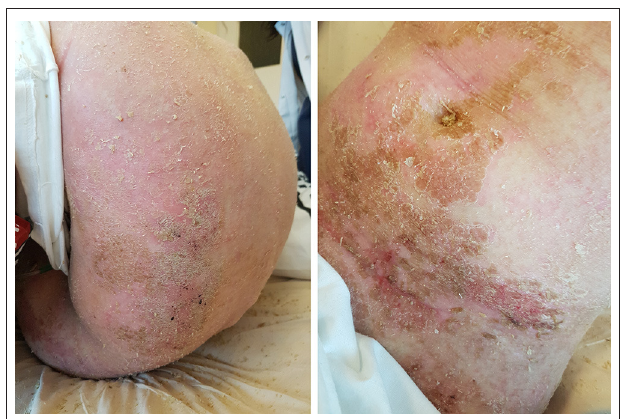
FIGURE 1 | Generalized ichthyosis linearis circumflexa on the patient’s trunk.